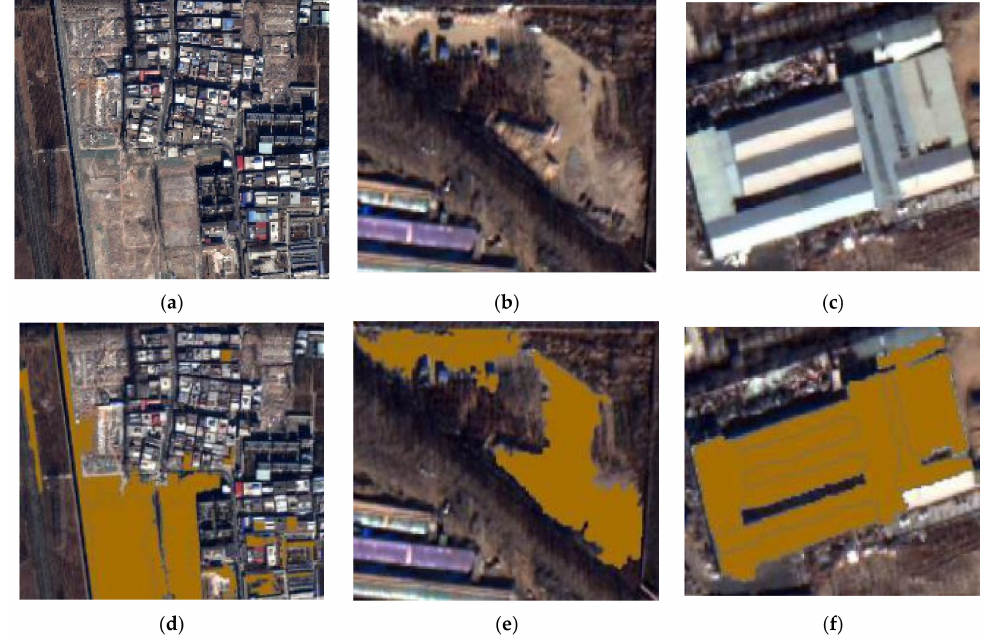
Figure 18. Classification results for GLCM homogeneity: ( a – c ) buildings with uniform texture are also separated by this feature, ( d,e ) the separated bare soil area, ( f ) the separation result of the flat